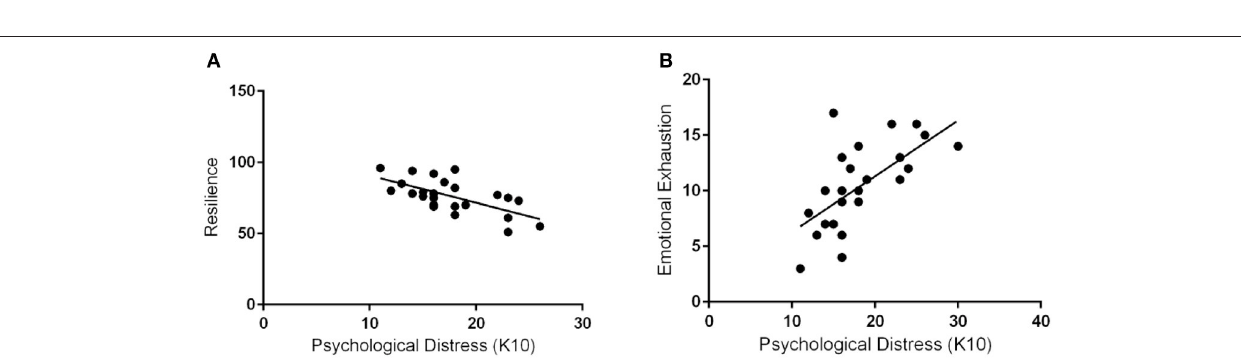
FIGURE 6 | Psychological distress negatively correlates with resilience and positively correlates with emotional exhaustion. Scores on the Kessler Psychological Distress Scale (K10) correlated negatively with scores on the Resiliency Quiz ( A , p < 0.001) and positively with emotional exhaustion scores ( B , p <